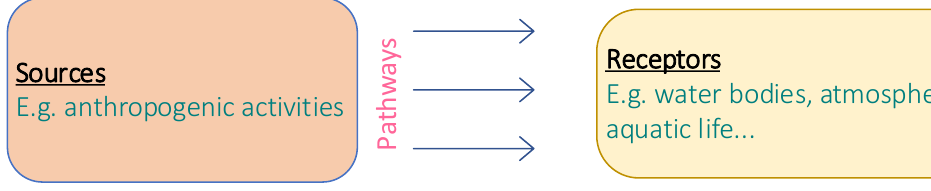
Figure 6. Environmental impact